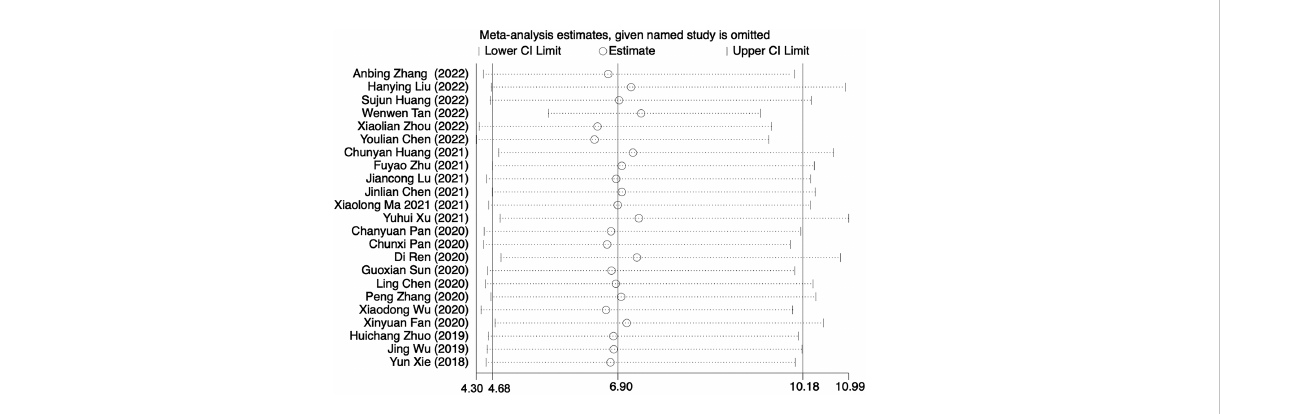
FIGURE 3 Sensitivity analysis of mNGS and conventional methods group.